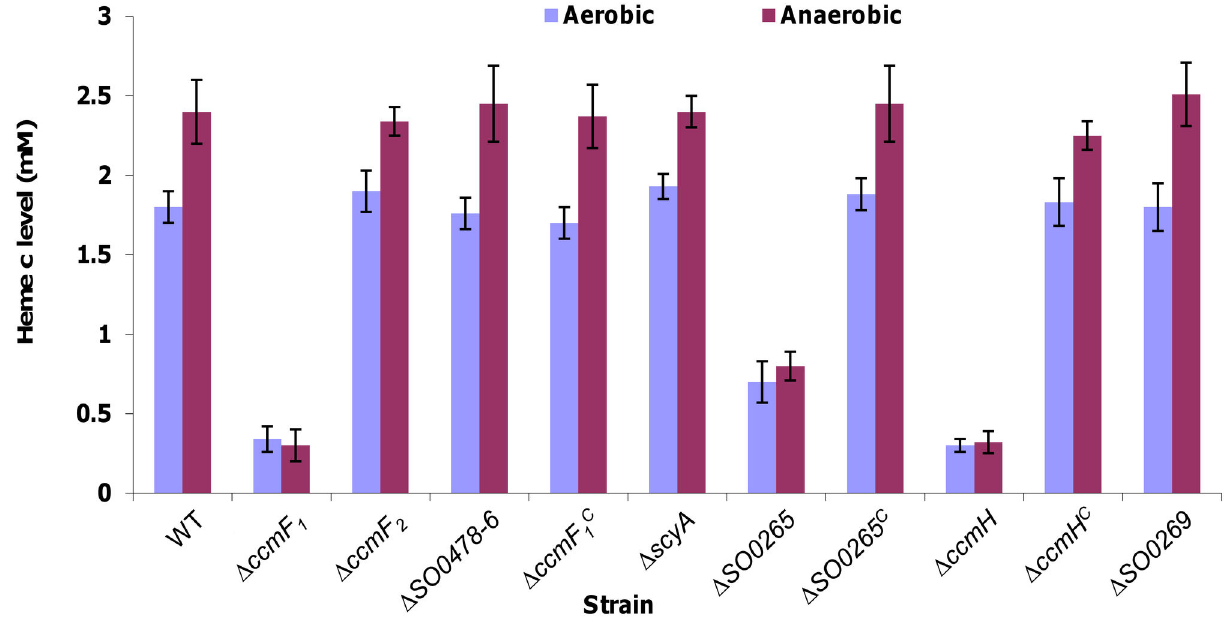
Figure 4. Heme c levels in S. oneidensis strains. wild type, ∆ ccmF1 , and ∆ ccmF2 strains. Mid-logarithmic growing cells (OD ~ 0.4 and ~ 0.15 under aerobic and anaerobic conditions respectively) were collected for the heme c assay. ∆ ccmF 1c and ∆ SO0265 c represents the mutants carrying pHG102- ccmF and pHG102- SO0265 , respectively. All other strains carry empty vector pHG102. 1 Three independently collected samples were assayed and the averaged levels were presented in mM per g of proteins. Error bars represent the standard deviations of the